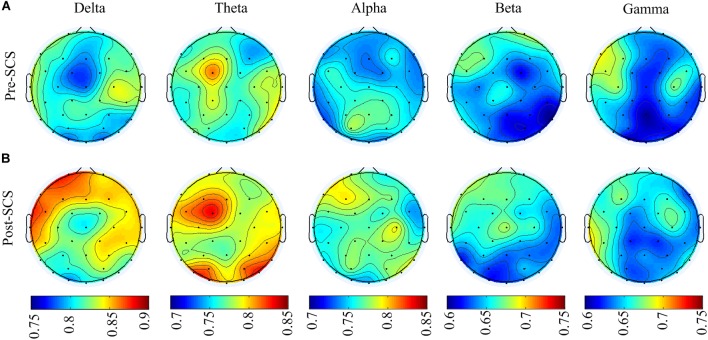
(A) Spatial distribution topographic of the non-zero GDFAE at each frequency band in pre-SCS state. (B) Topographic of the post-SCS state.